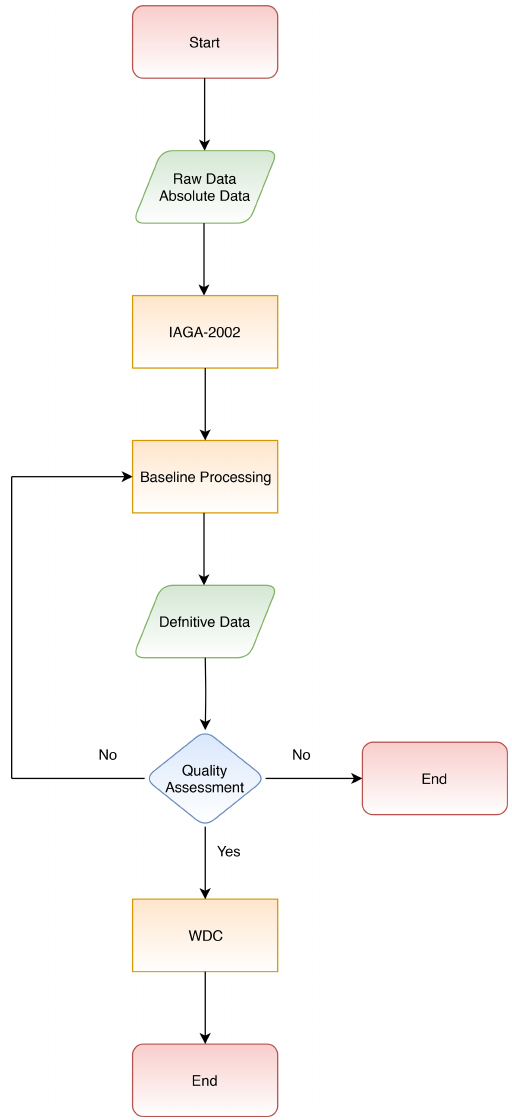
Figure 2. Flow chart to produce definitive data and quality assess- ment.